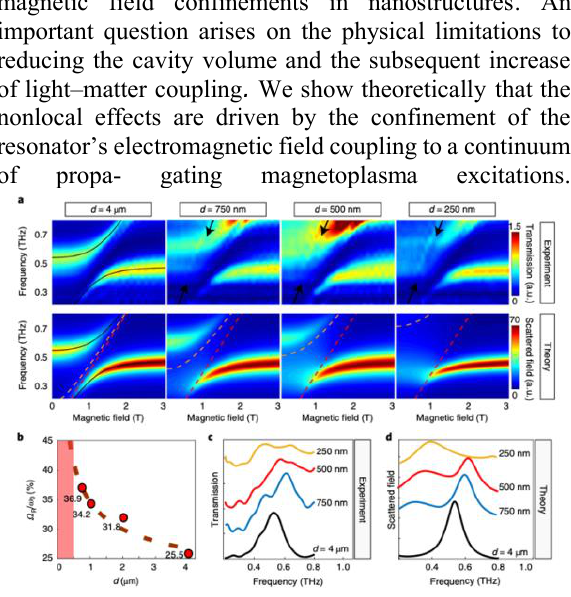
Fig. 1. a) T op row: transmission of cSrrs coupled to the Landau level transition in 2DEG versus magnetic field for four different gap sizes, d . . bottom row: the calculated scattered field for different gap feature sizes, d (same as the gap sizes of the experiment results). b , Normalized coupling versus d . The red-shaded region corresponds to where the large broadening of UP does not allow a measurement of the coupling. c , d , Sections (offset for clarity) of the colour plots in a at zero magnetic field for the experimental result ( c ) and the theoretical calculation ( d )